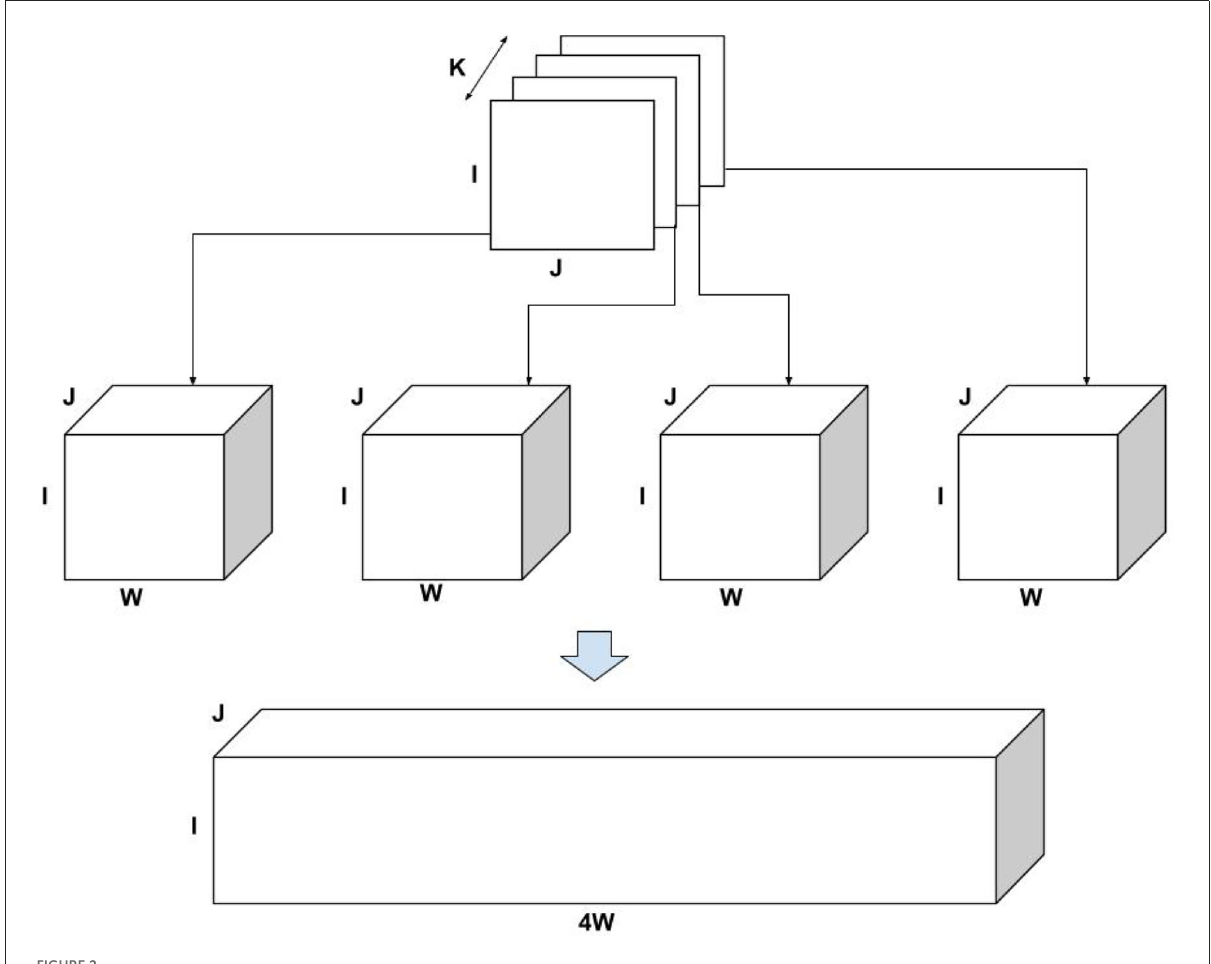
FIGURE2 Creating synthetic data.